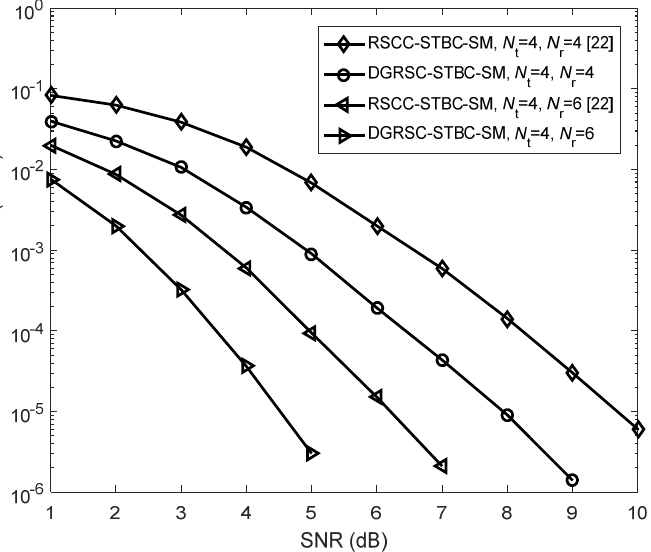
Figure 11. Performance comparisons between the DGRSC − STBC − SM scheme (using Algorithm 2 ) and the existing RSCC − STBC − SM [22] scheme (using random selection) under the conditions of 4 − QAM, λ S , R = ∞ , C S ( 63, 51, 13 ) and C R ( 63, 31, 33 ).